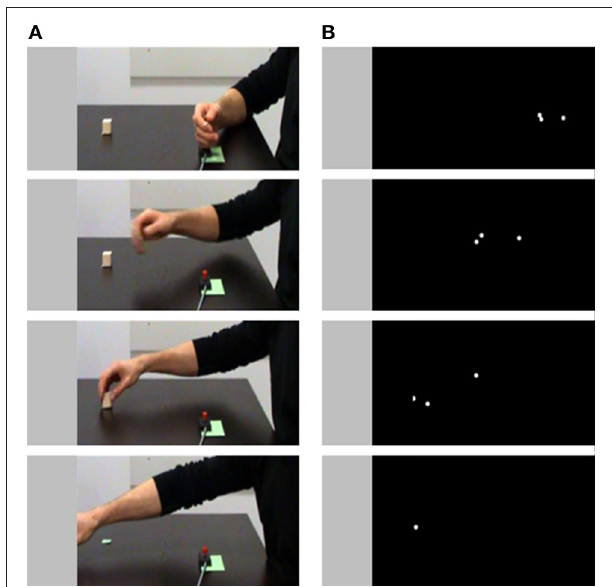
FIGURE 2 | Examples of stimuli used in to investigate the contribution of motor information to intention understanding. (A) Single frames extracted from a video clip representing an individual cooperative action sequence. (B) Single frames extracted from a point-light clip representing the same cooperative action sequence. Adapted from Manera et al.